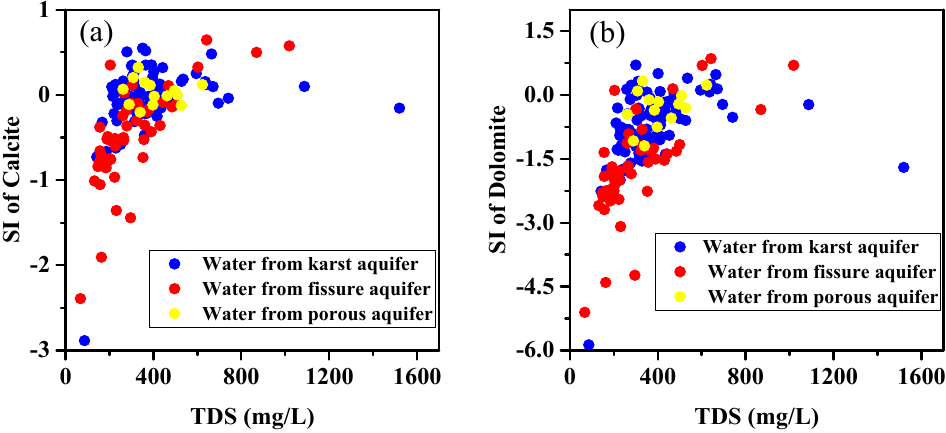
Figure 3. Correlation between total dissolved solid (TDS) and saturation index (SI) of ( a ) calcite and ( b ) dolomite in the study area.